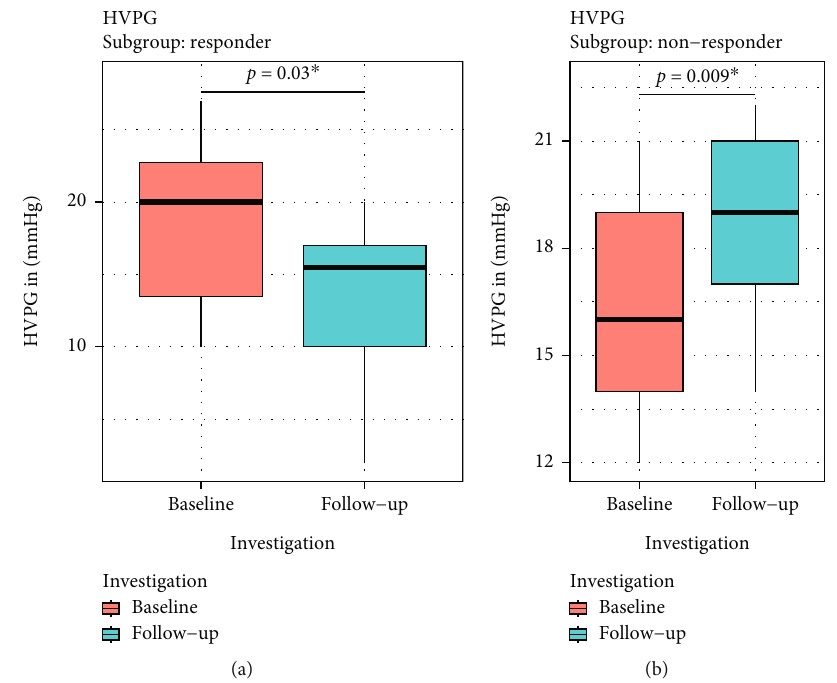
Figure 2: Results of the baseline and follow-up HVPG measurements in the responder and the non-responder group (a=responder, b =non-responder, red =baseline, blue=follow-up, ∗ =signi fi cant result) showing a signi fi cant decrease in HVPG results in the responder group (HVPG=hepatic venous pressure